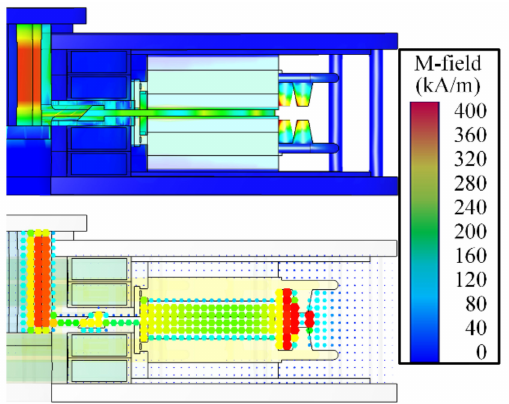
Figure 22. Cross-sectional view of the magnitude and vector diagram of magnetic field intensity at the instant of maximum load